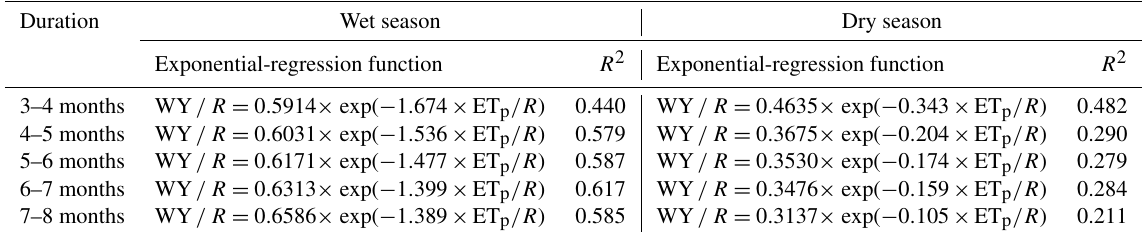
Figure 13. Relationship between the dryness index and water yield to rainfall ratio (WY /R ) on a seasonal basis and classified according to the duration of the wet season (from shortest to longest denoted by reddish and bluish colors in the color bar) pertaining to the dynamic approach for the wet season (a) and the dry season. The exponential-regression equations are represented in both plots by the dashed black lines according to the duration of the rainy period. Table 6. Exponential-regression models, with the corresponding coefficient of determination ( R 2 ), for the wet and dry seasons as a function of the duration of the rainy